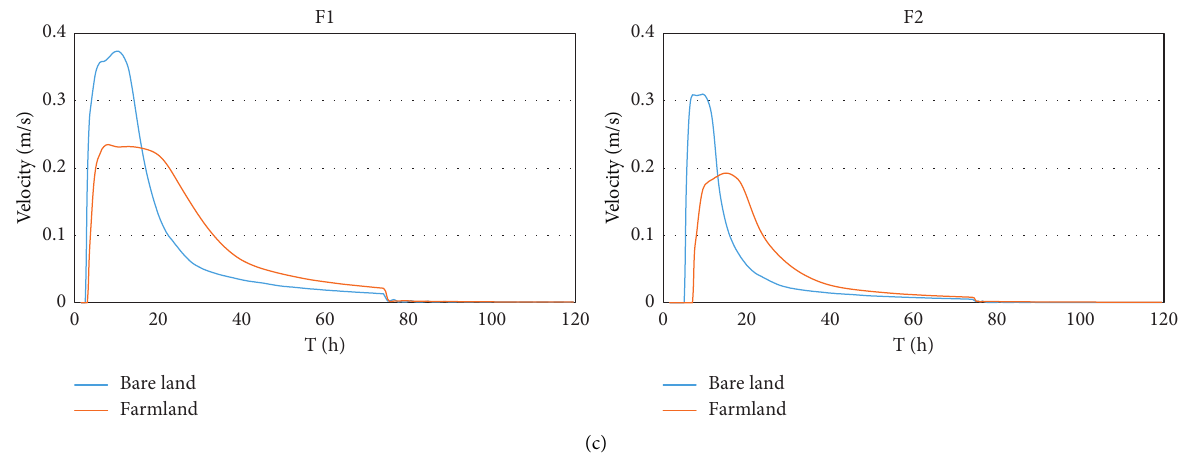
Figure 11: Comparison of the simulated water depths and velocities with varied land uses. Simulation of flood-related water pollution in the HTL. (a) Comparison of the flow depth between bare land and farmland. (b) Comparison of the flow depth between bare land and residence. (c) Comparison of the flow velocity between bare land and